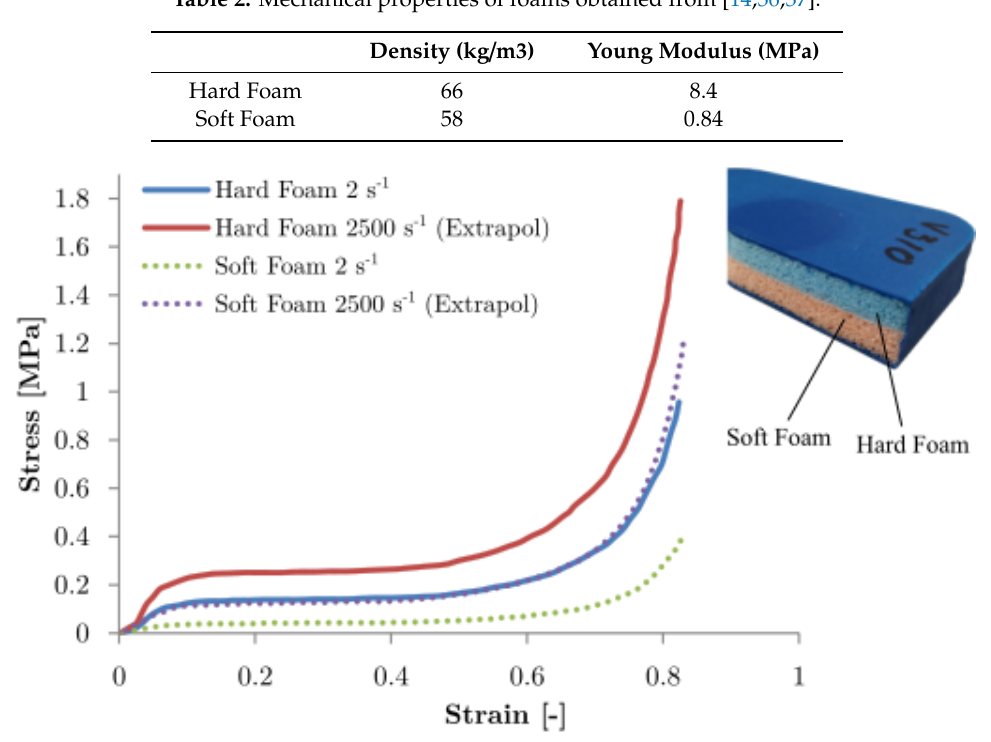
Table 2. Mechanical properties of foams obtained from [14,36,37].